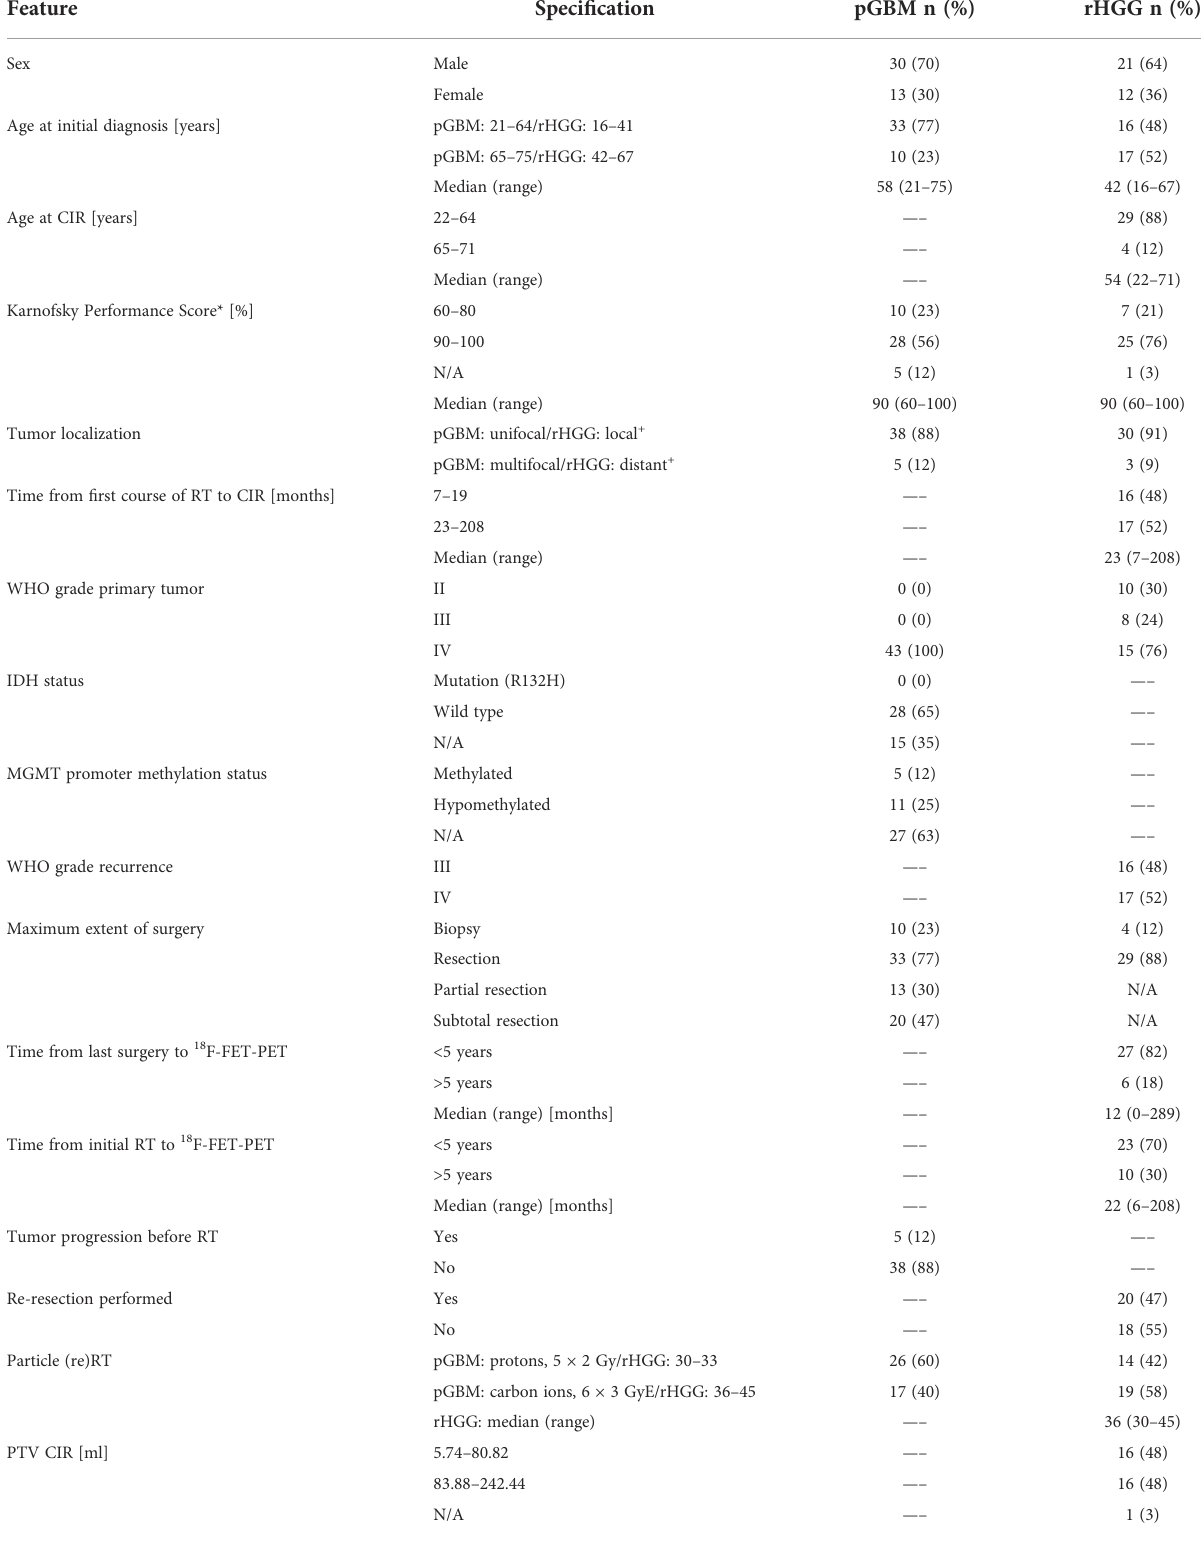
TABLE 1 Combined table of treatment and patient characteristics for the pGBM (n = 43) and rHGG (n = 33) cohorts.